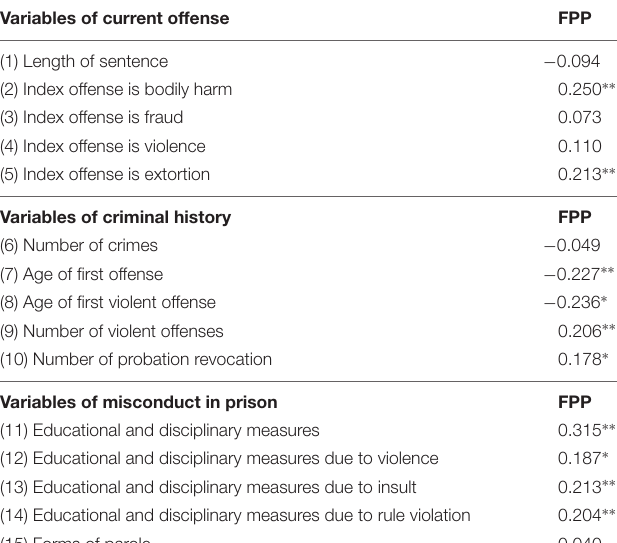
TABLE 7 | Spearman rank correlations r of FPP and criteria in a sample of inmates ( n from 109 to